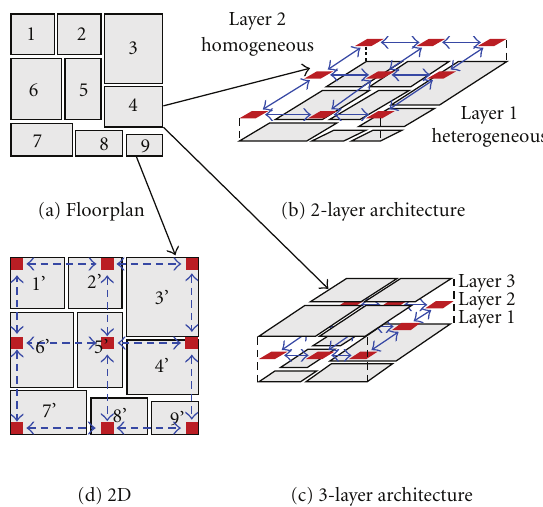
Figure 2: (a) Initial floorplan with no routers. (b) 2-layer archi- tecture. (c) 3-layer architecture. (d) 2D implementation with each IP/core inflated to account for area required by network interfaces, routers and wires for physical